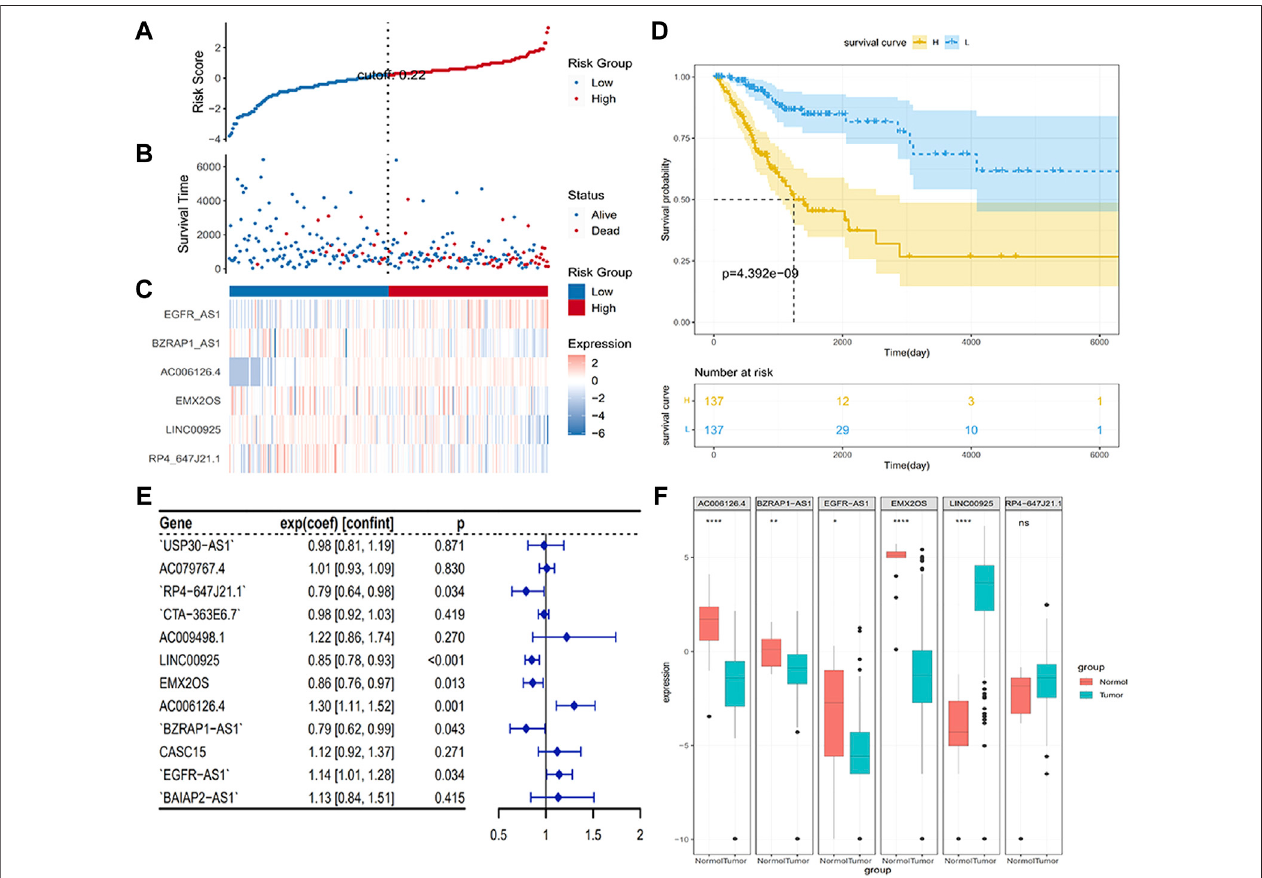
FIGURE 2 | Establishment of hub genes and distributions. (A,B) Survival states of patients depending on hub signature levels; (C) Heatmap plot was used to determinevariantlevelsinhubsignaturesidenti fi edbetweendifferentgroups; (D) Kaplan – Meieranalysiswiththehubimmunesignature; (E) Forestplotvisualizedresults of multivariate Cox regression analysis; (F) Differences in expression levels of six hub genes in different groups.